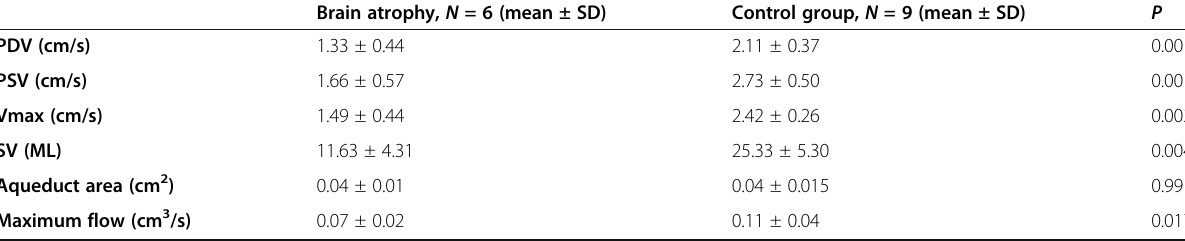
Table 5 Analysis of difference between brain atrophy group versus control ( t test)